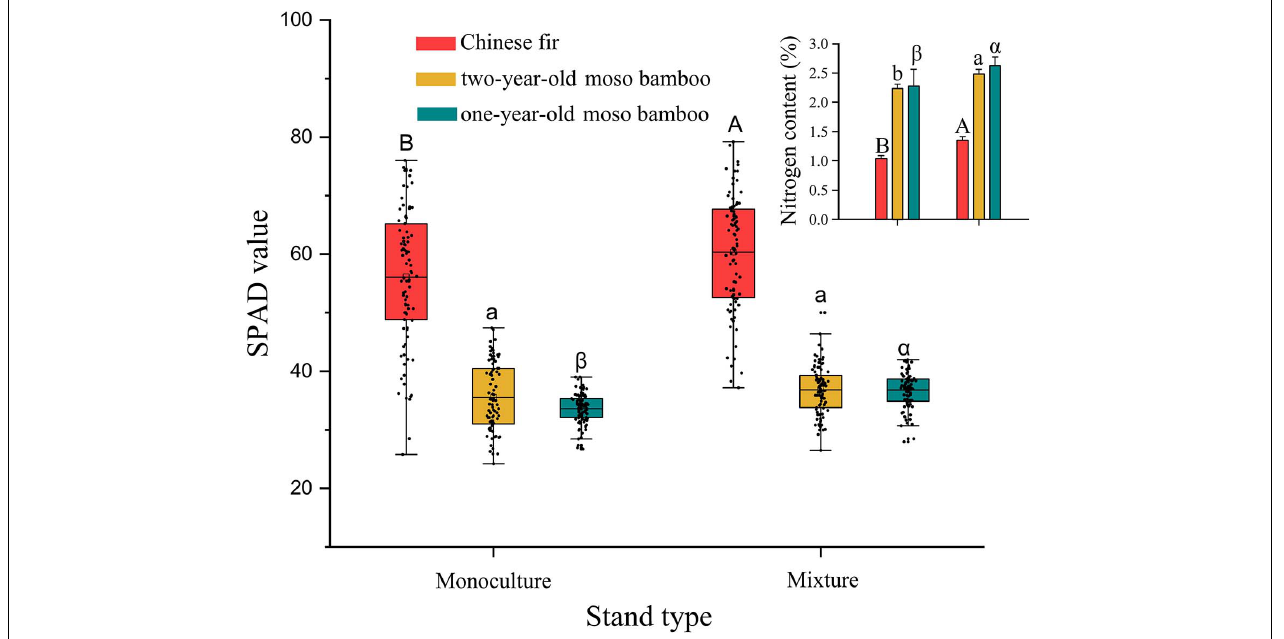
FIGURE 5 | Chlorophyll content and leaf N content in moso bamboo and Chinese fir leaves in different stand types. Capital letters indicate significant differences between Chinese fir under monoculture and mixed-stand conditions ( P < 0.05). Lowercase letters indicate significant differences between 2-year-old moso bamboo under monoculture and mixed-stand conditions ( P < 0.05). Greek letters indicate significant differences between 1-year-old moso bamboo under monoculture and mixed-stand conditions ( P <